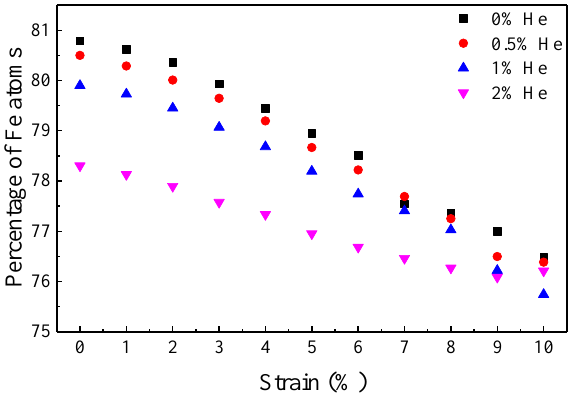
Figure 4. The percentage of iron atoms in BCC region as a function of strain.